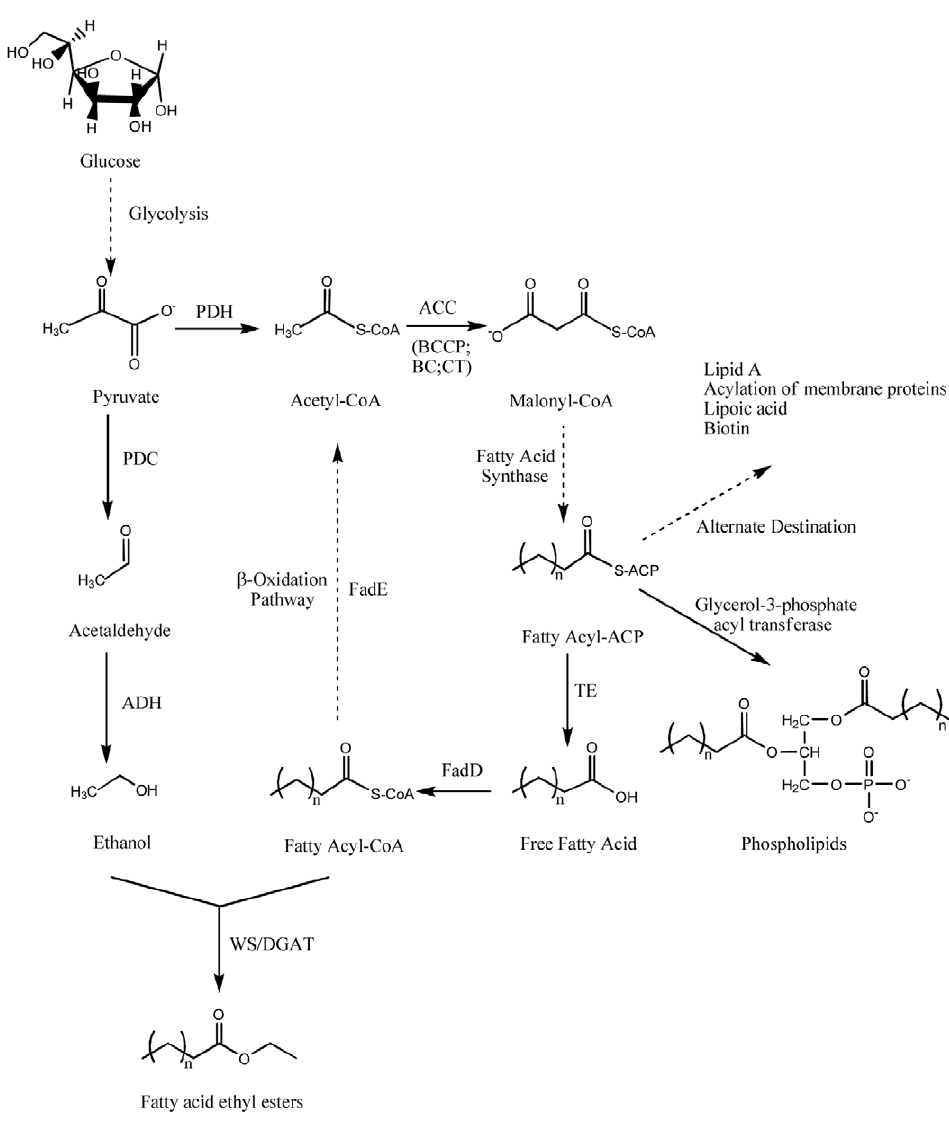
Figure 1. Constructed denovo biosynthetic pathway of fatty acid ethyl esters in E.coli . PDH: pyruvate dehydrogenase; ACC: acetyl-CoA carboxylase; BCCP: biotin carboxyl carrier protein; BC: biotin carboxylase; CT: carboxyltransferase; PDC: pyruvate decarboxylase; ADH: alcohol dehydrogenase; TE: thioesterase; FadD: fatty acyl-CoA synthase; FadE: acyl-CoA dehydrogenase; WS/DGAT: wax synthase/acyl-coenzyme A: diacylglycerol